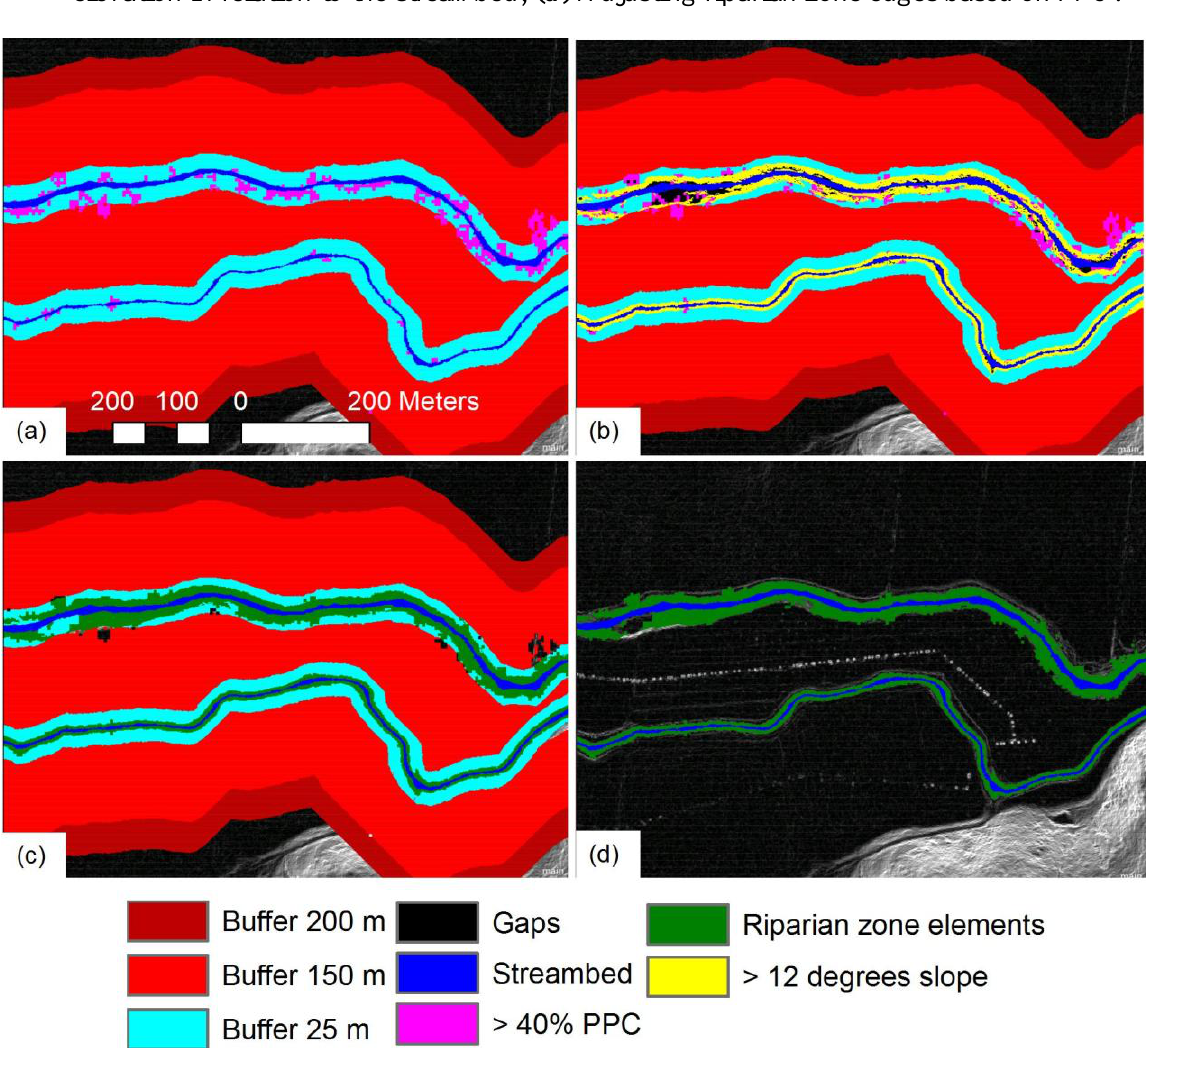
Figure 5. Mapping riparian zone extent from the LiDAR derived DTM, slope, PPC and streambed layers. The slope layer is used as a backdrop. ( a ) Buffers and mapping of streamside woody vegetation with more than 40% plant projective cover; ( b ) Mapping of stream banks based on slope; ( c ) Mapping of riparian zone extent adjusted based on elevation in relation to the streambed; ( d ) Adjusting riparian zone edges based on